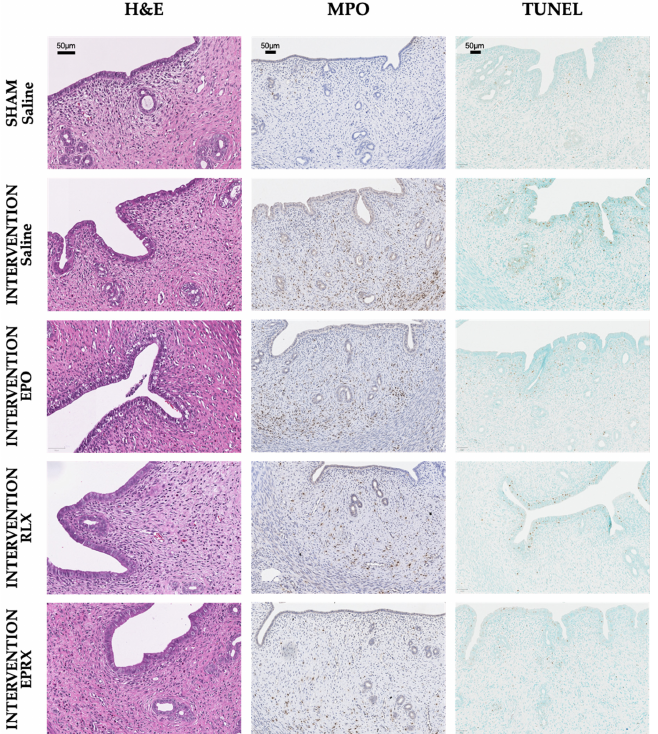
Figure 2. Micrographs of histological changes, MPO expression and TUNEL-positive cells in uterine tissue between sham + saline and all intervention groups. H&E—hematoxylin and eosin, MPO— myeloperoxidase, TUNEL—terminal deoxynucleotidyl transferase-mediated dUTP nick-end labeling EPO—erythropoietin, RLX—relaxin, EPRX—erythropoietin and relaxin. 2.3. Gene Expression after Ischemia–Reperfusion Injury Real-time quantitative polymerase chain reaction (qPCR) analysis revealed changes in several inflammatory and apoptosis genes between experimental groups in rat uterine tissue. No changes in the expression of iNOS, NFKB1, HIF1, BAX, BCL2, MCP1 and CXCL2 genes were detected after reperfusion in rat uterus tissue (Figure 3). Pretreatment with RLX combined with EPO significantly upregulated the expression of eNOS, IL10, NICD and HES1 1.25- ( p = 0.029), 2.65- ( p = 0.030), 1.27- ( p = 0.019) and 1.22- fold ( p = 0.035), respectively. Furthermore, RLX alone resulted in significantly upregulated